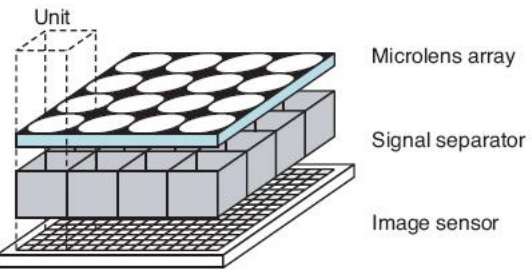
Figure 8. Hardware configuration of the TOMBO system.